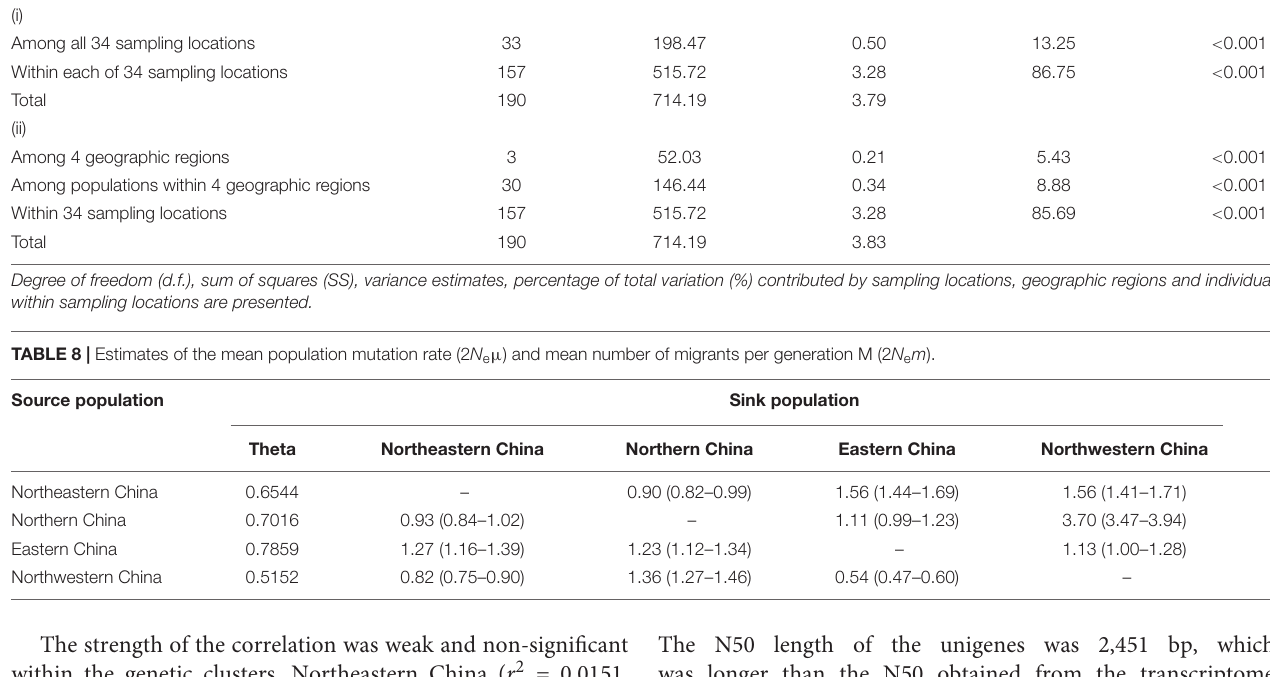
TABLE 7 | Analysis of molecular variance (AMOVA) for Alternaria tenuissima populations based on (i) sampling locations, and (ii) four geographic regions. Source of variation d.f. SS Variance % P -values